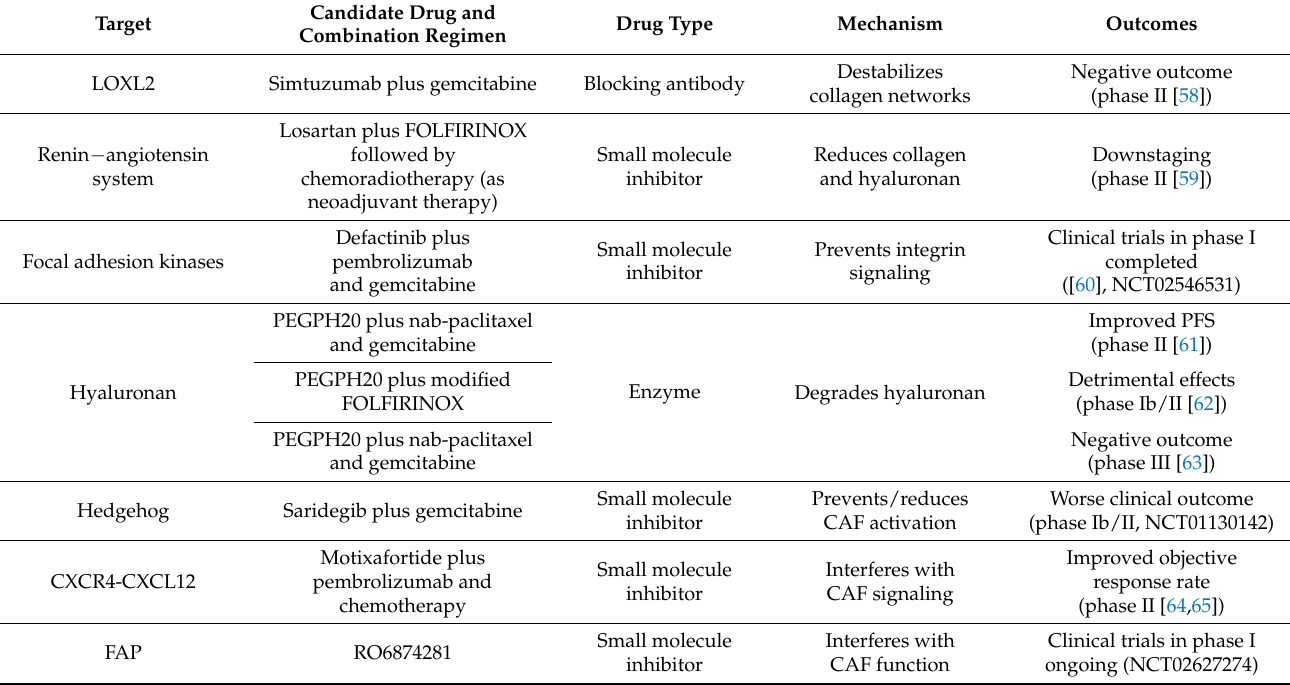
Table 1. Selected therapeutic stromal targets and clinical